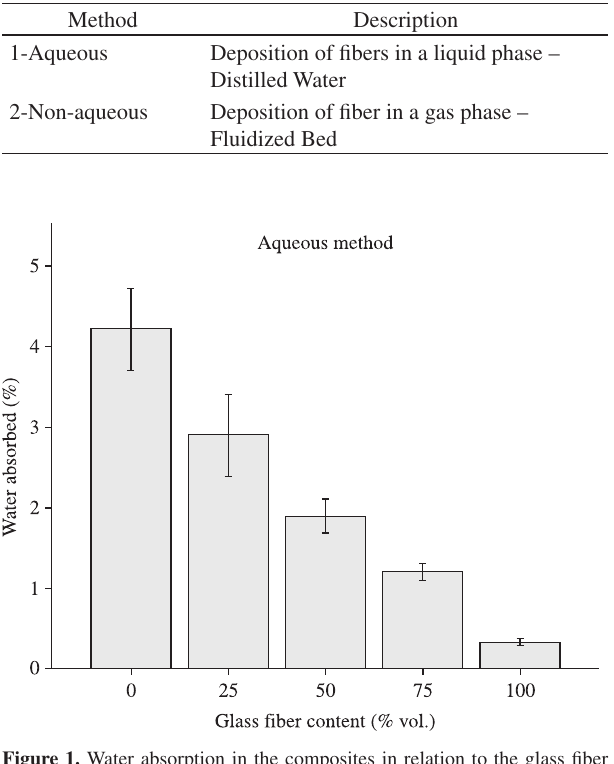
Figure 1. Water absorption in the composites in relation to the glass fiber content - Aqueous method.